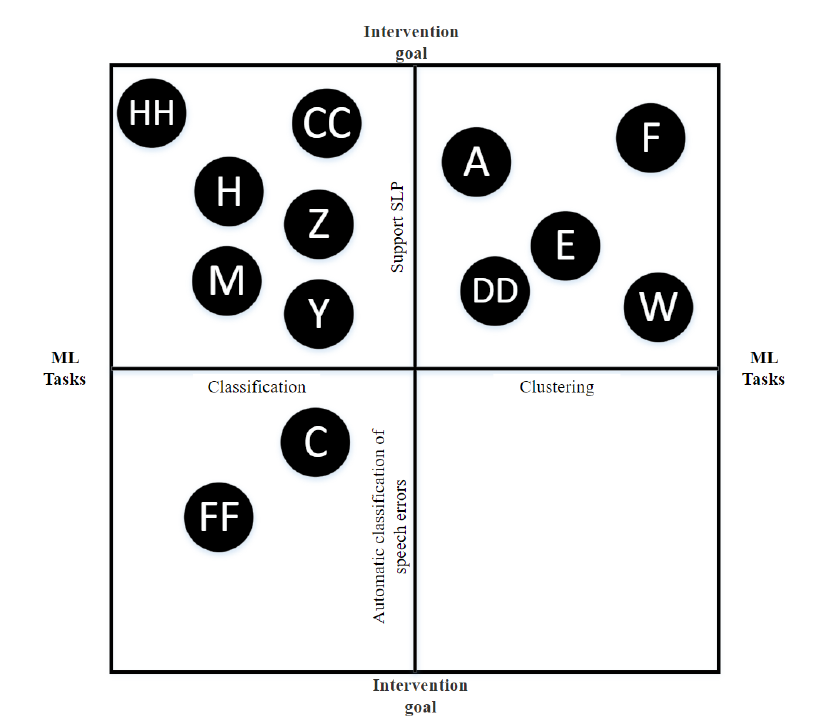
Figure 7. Bubblechart of ML approaches and OST goals.